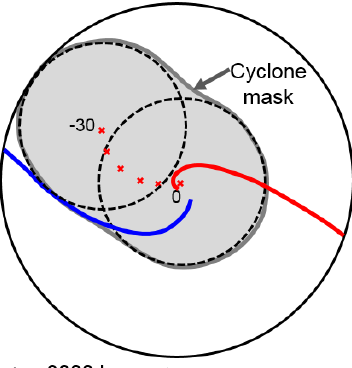
Figure 2. Schematic of cyclone-masking method. Red and blue lines show the approximate position of the cyclone warm and cold front respectively. Red crosses show the position of a given cyclone at time ( t ) and at 6-hourly intervals up until 30h previously ( − 30). The outer circle shows the 30 ◦ radius circle used to produce the composites in Figs. 5 to 8. The smaller dashed circles show exam- ple locations of a 14 ◦ radius circle centred on the cyclone position at t = 0 and t = 30. The grey shading shows the extent of the cyclone mask, encompassing the cyclone’s centre and cold